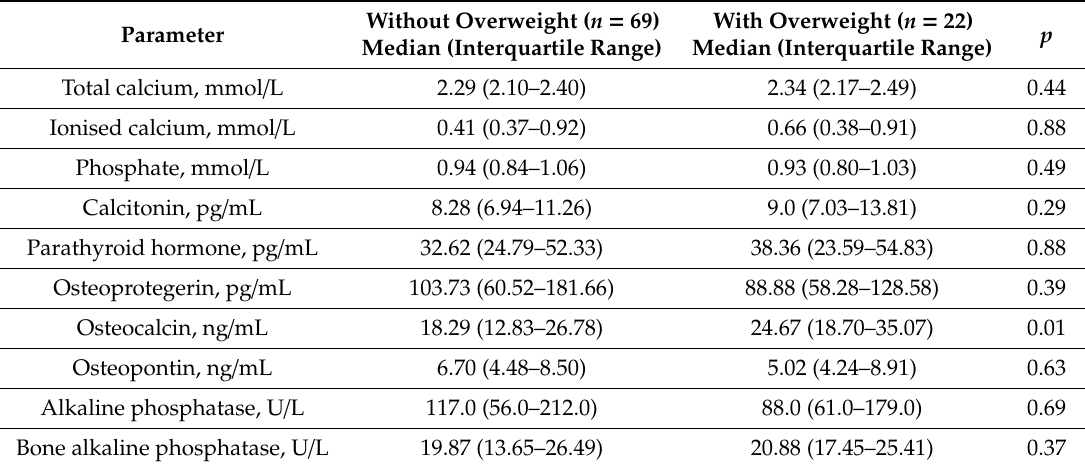
Table 5. Parameters of mineral homeostasis in relation to the patients with overweight (body mass index ≥ 25 kg / m 2 ).